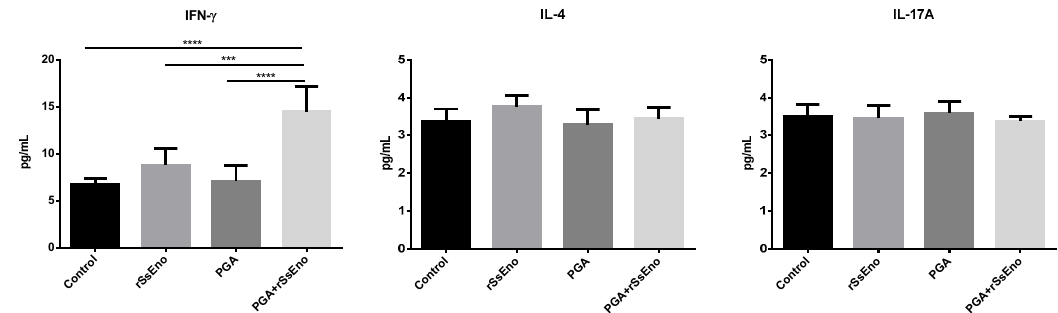
Figure 4. Cytokine profile in supernatant of splenocytes stimulated in vitro with rSsEno. Balb/c mice were immunized (s.c.) twice with rSsEno, PGA, PGA+rSsEno, or PBS as negative control. Splenocytes of each animal were collected seven days after the second immunization and purified cells were stimulated in vitro with rSsEno. Cytokine were quantified by cytometric bead array (CBA). * ( p < 0.05); ** ( p < 0.01); *** ( p < 0.001): **** ( p < 0.0001).